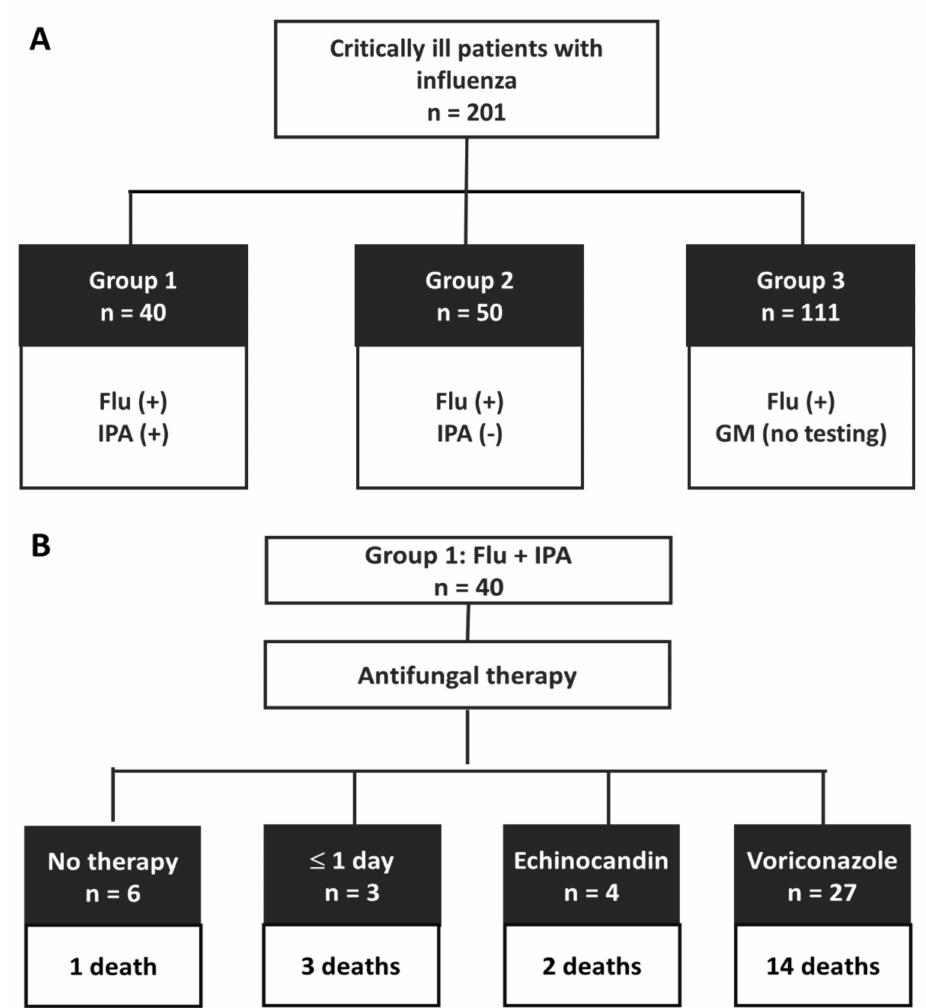
Figure 1. A total of 201 critically ill patients with positive testing for influenza were enrolled and were classified into three groups ( A ) and clinical outcome of group 1 ( B ) in real-world data from 2016 to 2018. Note. Flu, influenza assay; GM, galactomannan assay; (+), positive result; (-), negative